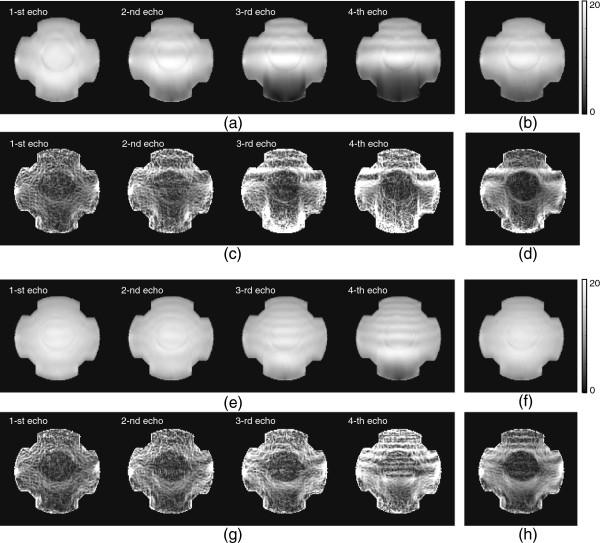
MeasuredT2∗ weighted magnitude and magnetic flux densityBz images usingP0∪P+ withNc=5 andNc=10.a) and e)T2∗ weighted magnitude image at each echo timeTEm,m=1,2,3,4, with Nc=5 and Nc=10, respectively. b) and f) combinedT2∗ weighted magnitude image with Nc=5 and Nc=10, respectively. c) and g) recovered Bz image at each echo timeTEm,m=1,2,3,4 with Nc=5 and Nc=10, respectively. d) and h) weighted Bz image using multiple Bz image at each echo time with Nc=5 and Nc=10, respectively.